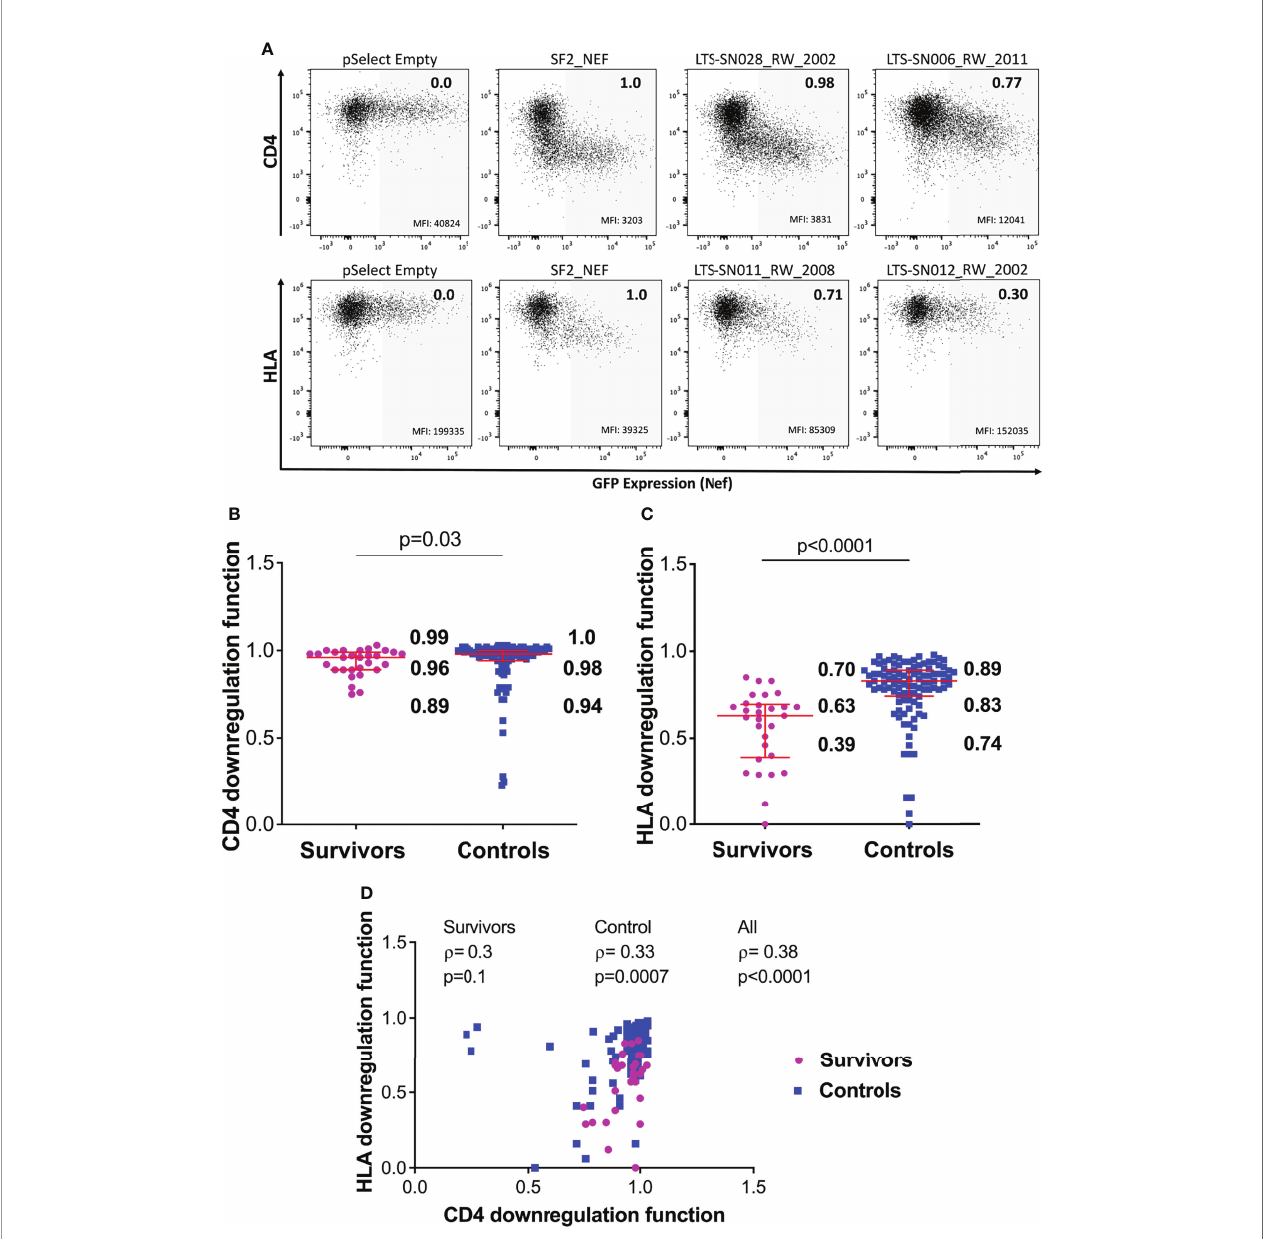
FIGURE 3 | Nef-mediated CD4 and HLA downregulation function in survivors and controls. (A) Representative fl ow cytometry plots showing downregulation of CD4 (top) or HLA (bottom) following transfection of negative control (pSelect empty vector), positive control (SF2 Nef), a representative functional clone and a representative poorly-functional clone. Gray shading denotes the GFP-positive (Nef-expressing) gate that was used for quanti fi cation. Median fl uorescence intensity (MFI) of receptor expression is indicated at the bottom of each gate, and the SF2-normalized downregulation function value (calculated as described in the Methods) is indicated in the top right of each plot. (B) Nef mediated CD4 downregulation functions of LTS and controls. Red box and whiskers denote the median and interquartile range, with values indicated on the plot. P-value is calculated using the Mann-Whitney U-test. (C) Comparison of Nef mediated HLA downregulation function among LTS and controls. (D) Relationship between Nef-mediated CD4 and HLA downregulation functions in individual and combined cohorts, assessed using Spearman ’ s